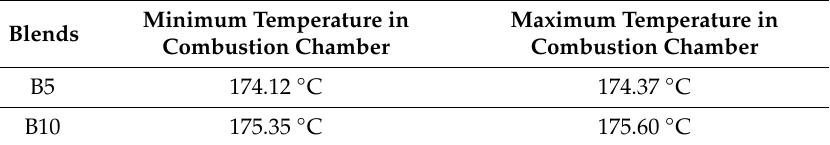
Figure 13. Maximum temperatures in the combustion chamber with the B10 mixture: ( a ) temperature in the chamber of 175.4 °C; ( b ) temperature in the chamber of 174.6 °C. Table 8. Result thermography